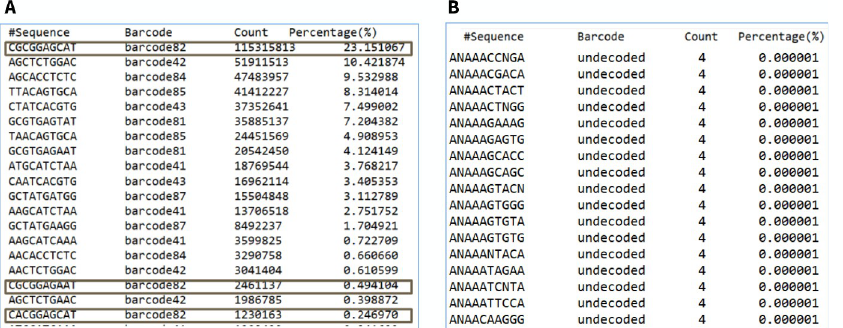
Fig 5. Example from the file SequenceStat.txt. A: barcode 82 was read in 23 percent of cases without error and in some cases with the recovery of the misread one nucleotide. B: read sequences of barcodes with more than two errors compared to the table of 96 sequences are assigned the status “undecoded".